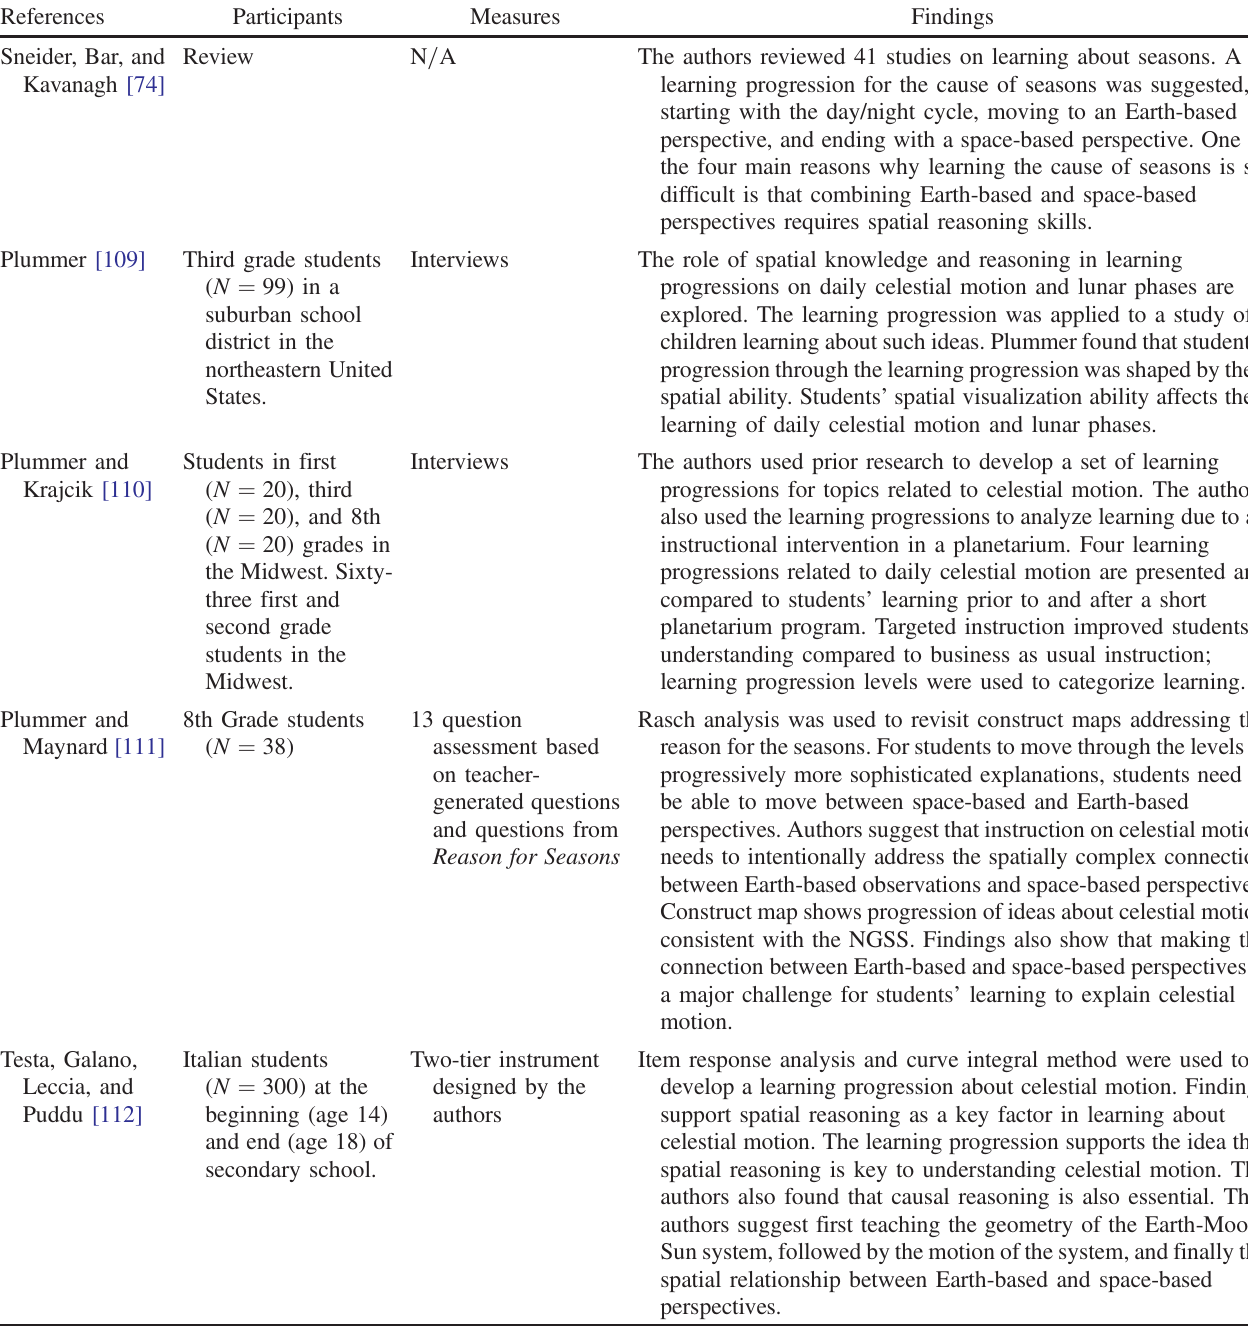
TABLE VIII. Summary table for learning